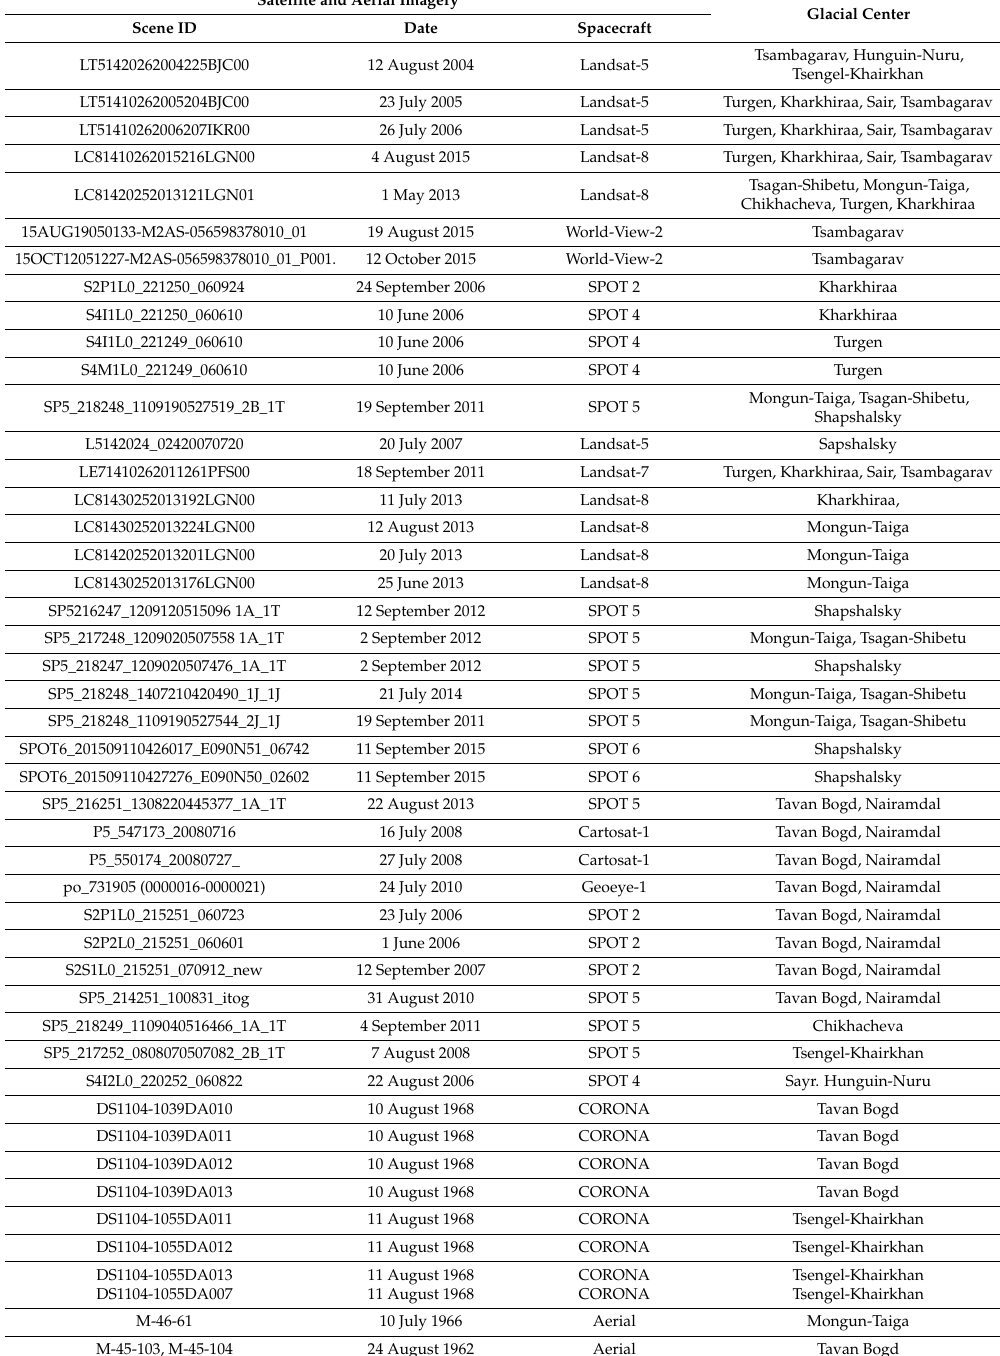
Table 1. Satellite and aerial imagery used in the glaciations